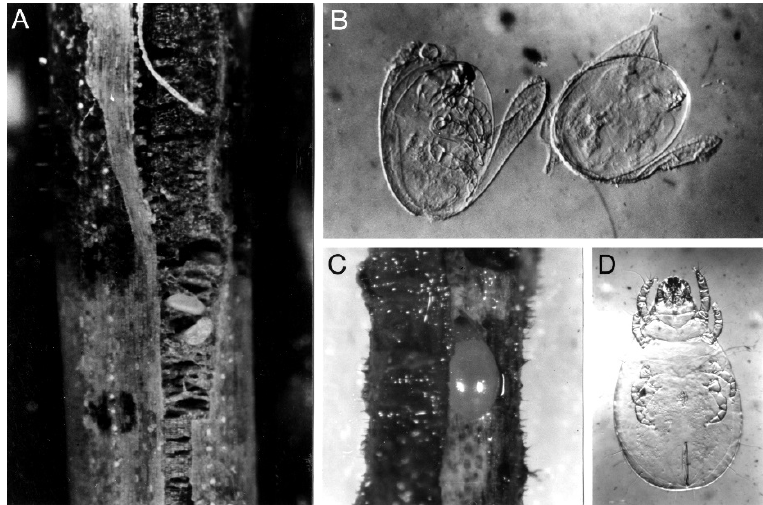
Figure 14. Developmental stages of the mite Adoristes ovatus : ( A ) Two newly laid eggs in a partly opened needle; ( B ) Eggs under hatching; ( C ) Deuteronymph (second last juvenile stage) within its cavity in an opened needle; ( D ) Tritonymph (last juvenile stage). From [15].